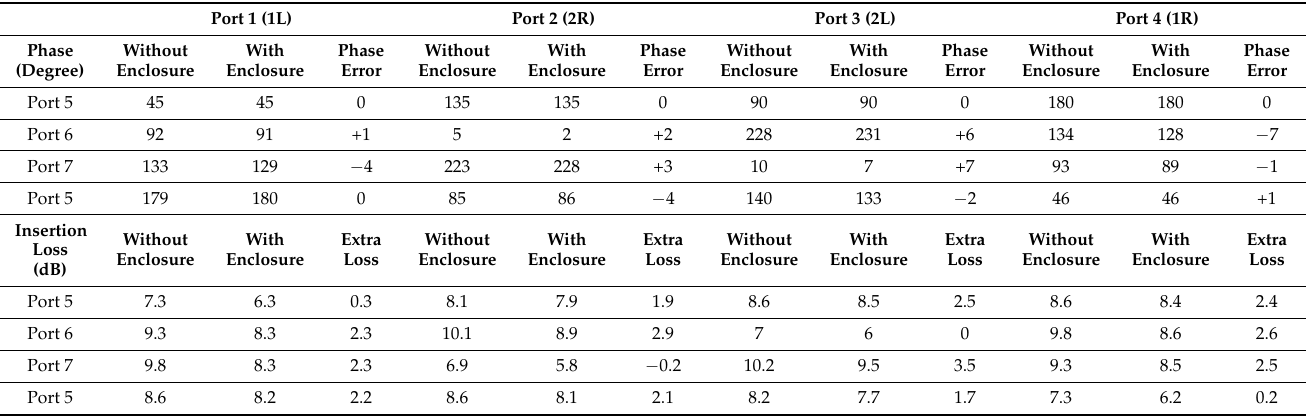
Table 1. Simulated performances of the Butler matrix.